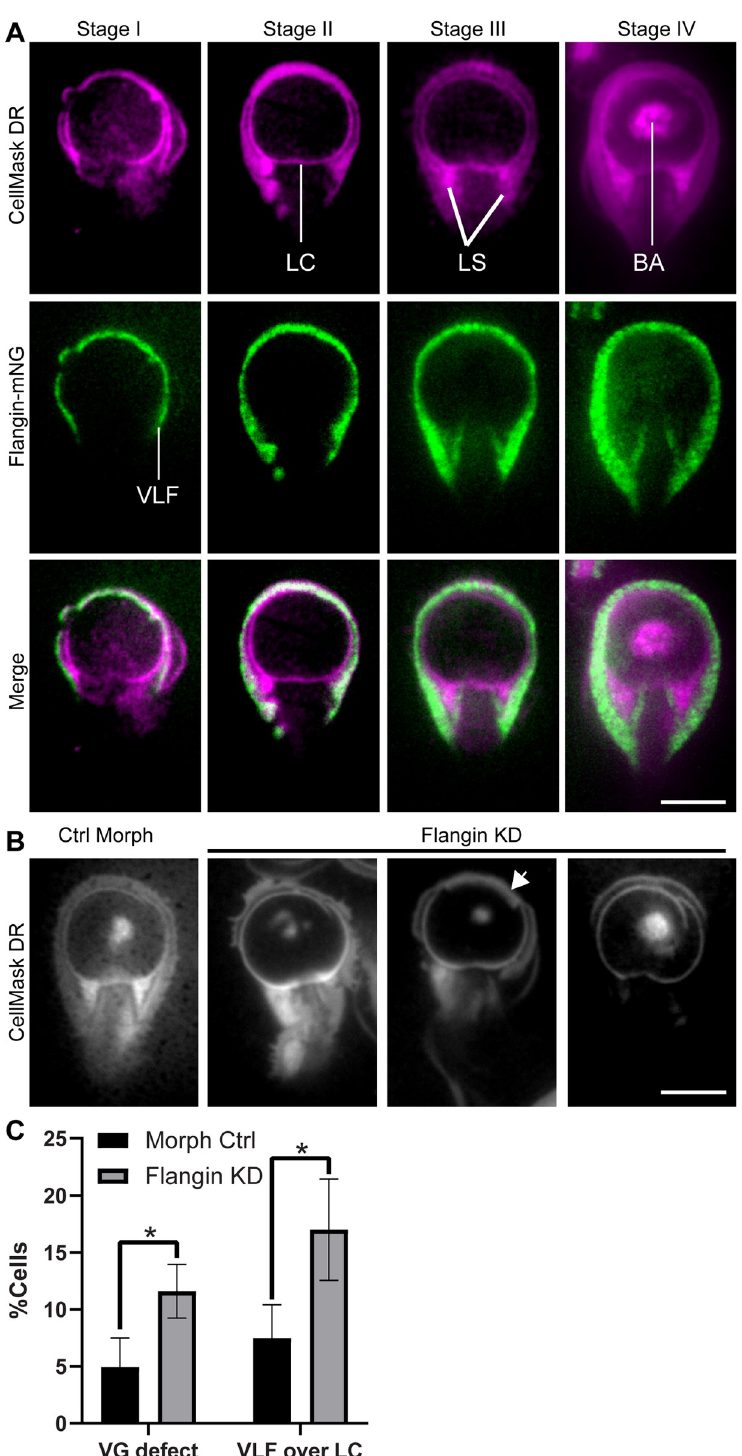
Fig 6. The flange makes intimate contact with attached surfaces and is required for normal ventral groove morphology. (A) Two color total internal reflection (TIRF) microscopy. Membranes are stained with CellMask Deep Red (magenta) and the flange is labeled with Flangin-mNG. As attachment progresses the flange becomes intimately associated with the substrate surface. (B) Knockdown of Flangin with translation blocking morpholinos uncouples the normal progression of attachment. Note that the ventral disc and bare area continues to make contact with the